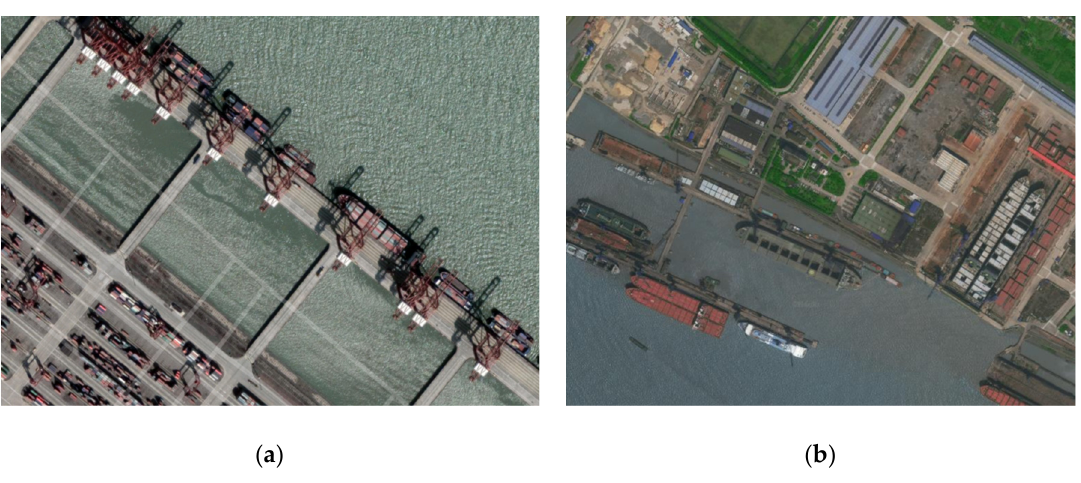
Figure 4. Two different satellite images from terminal candidates. ( a ) Satellite image of a real container terminal. ( b ) Satellite image of a repairing shipyard.